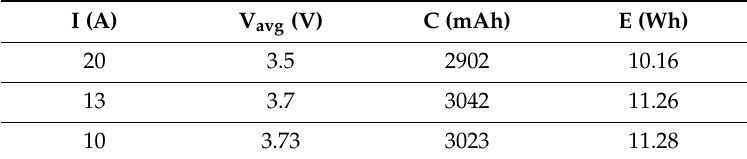
Table 4. Discharge tests results. V avg : average voltage; C: discharge capacity; E: extracted energy; I: current.